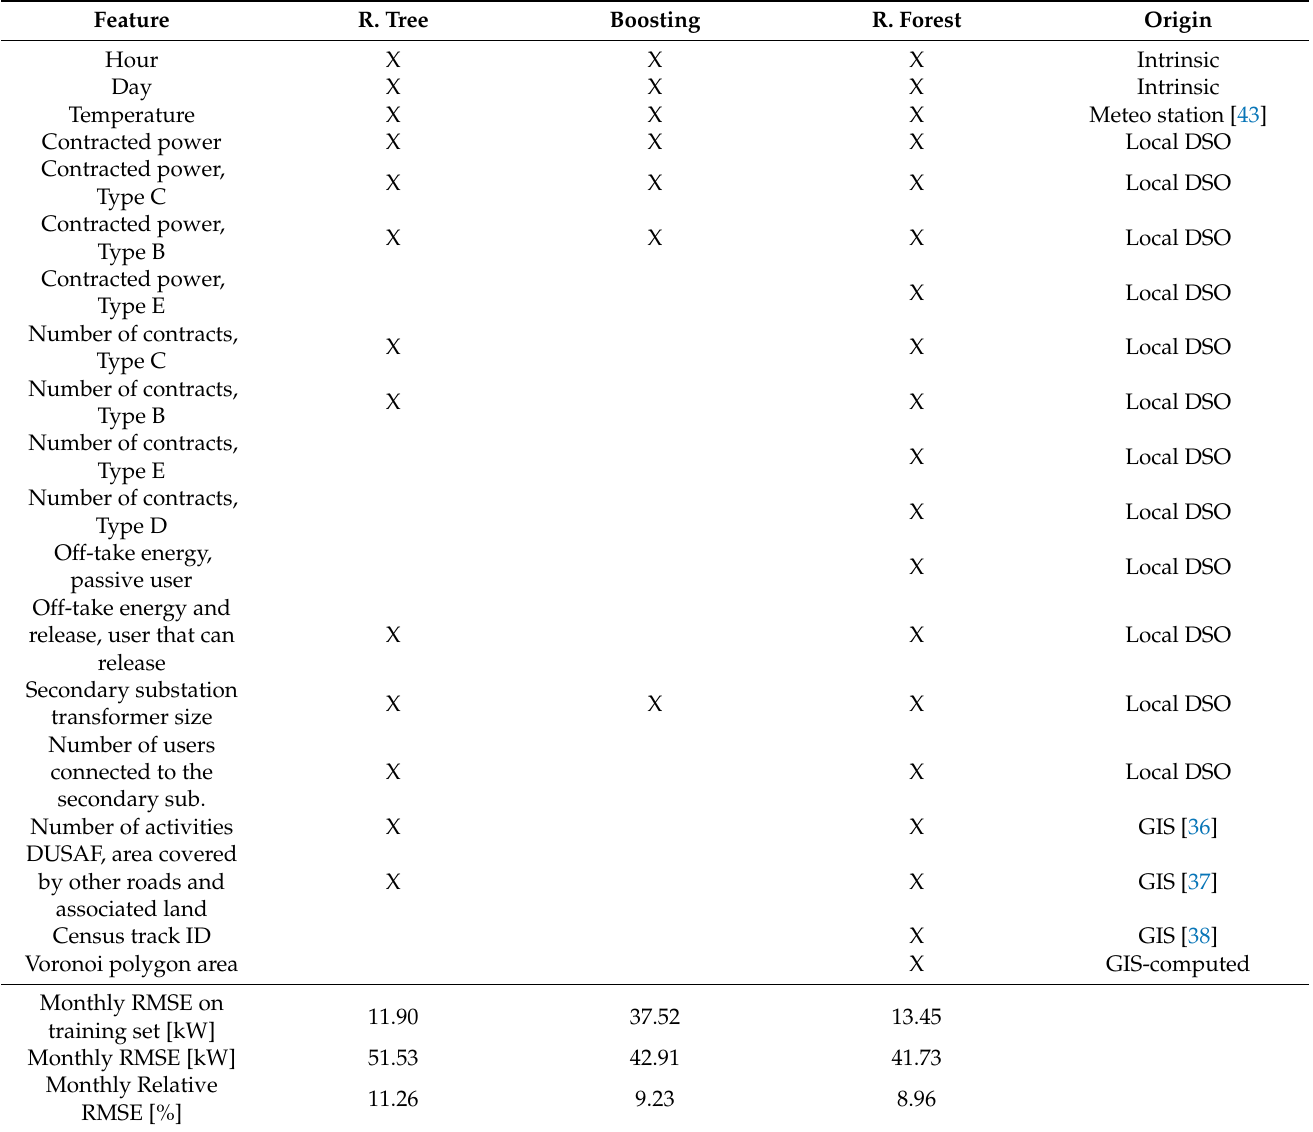
Table 1. Features used in the best models found with stepwise analysis and their source.